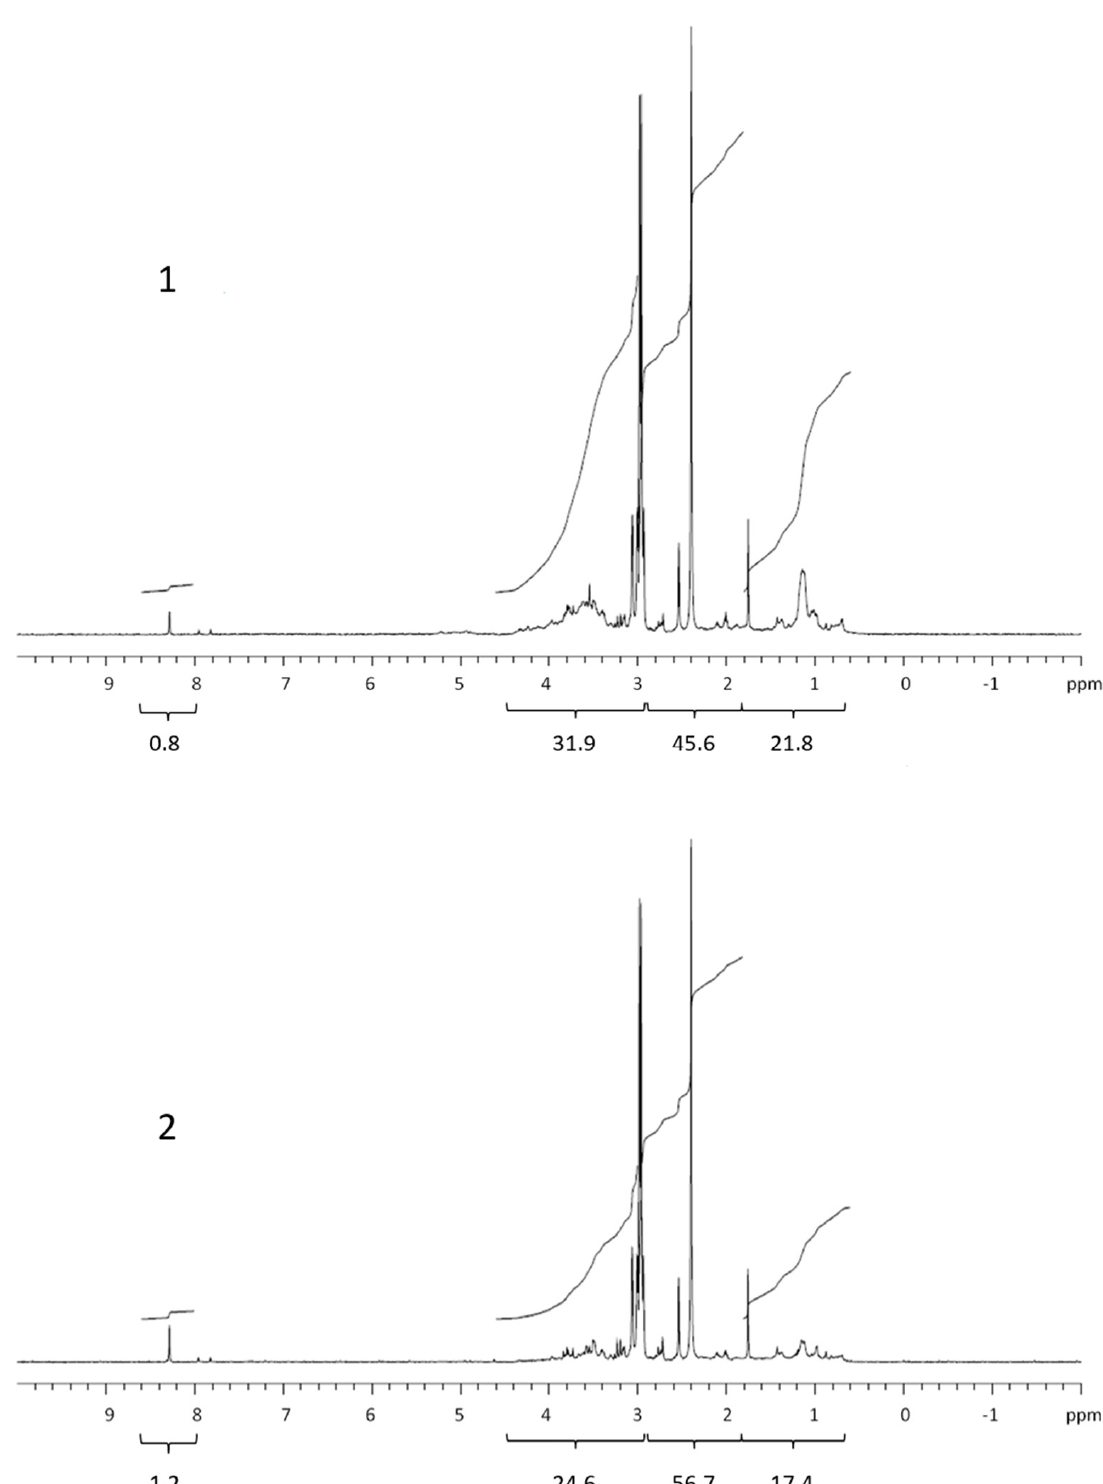
Figure 3. 1 H NMR spectra of retentate ( 1 ) and permeate ( 2 ) isolated from exudate of the dinoflagellate Prorocentrum minimum . Values below brackets are integrated values.